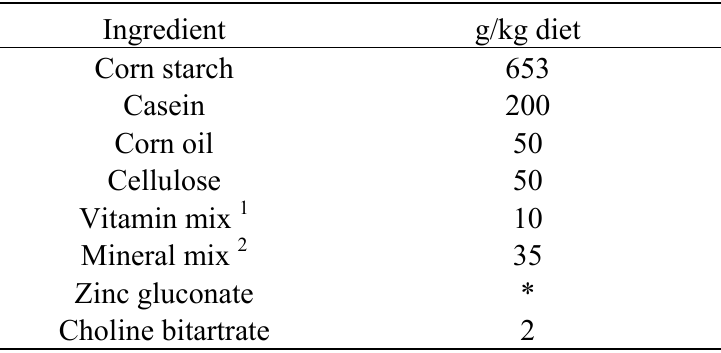
Table 1. Composition of experimental